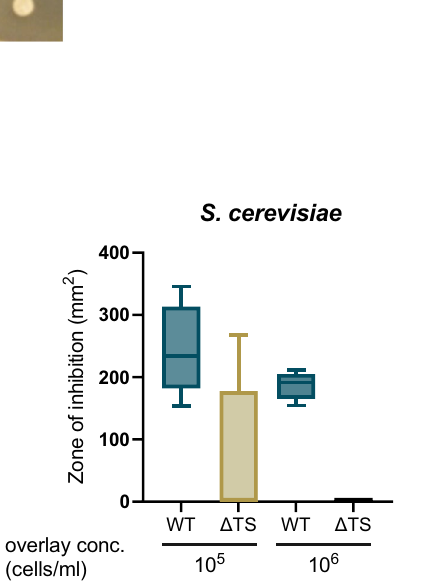
activity of Sco M145 strains was quanti fi ed by calculating the surface area of the zone of clearance around each colony. Results are shown as box plots. The center horizontal line denotes the median and boxes extend from the 25 th to the 75 th percentile of values, whiskers show the full range of value distribution per strain. n =6 biologically independent experiments in assays against M. luteus , n =8 in assays against S. cerevisiae (10 5 ) and n =6 in assays against S. cerevisiae (10 6 ). M1152 strains did not show any inhibitory activity against M. luteus or S. cerevisiae . Source data are provided in the Source Data fi